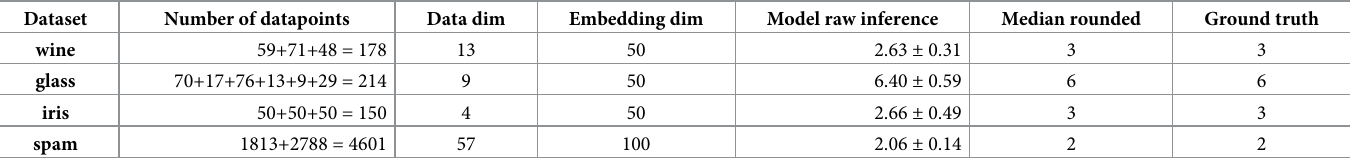
Table 1. Cluster number inference by hierarchical linkage regression for other real-world data (data source: UCI machine learning repository